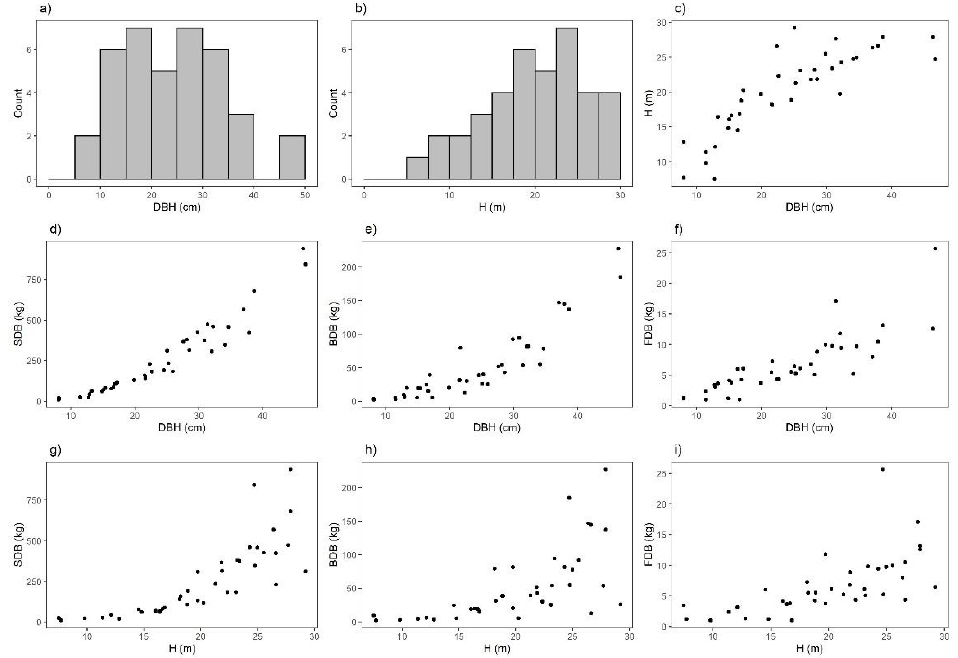
Figure 1. Diameter at breast height distribution (DBH, ( a )), height distribution (H, ( b )), H–DBH relationship ( c ), biomass components (SDB—stem dry biomass, BDB—branches dry biomass, FDB—foliage dry biomass)–DBH relationship ( d – f ), biomass components–H relationship ( g – i ) of black locust sample trees.